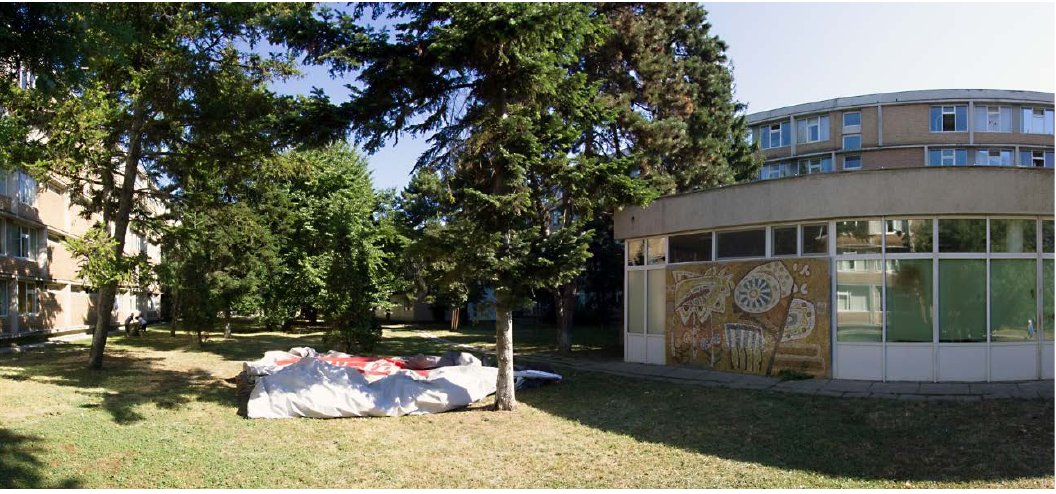
Figure 12: The chosen